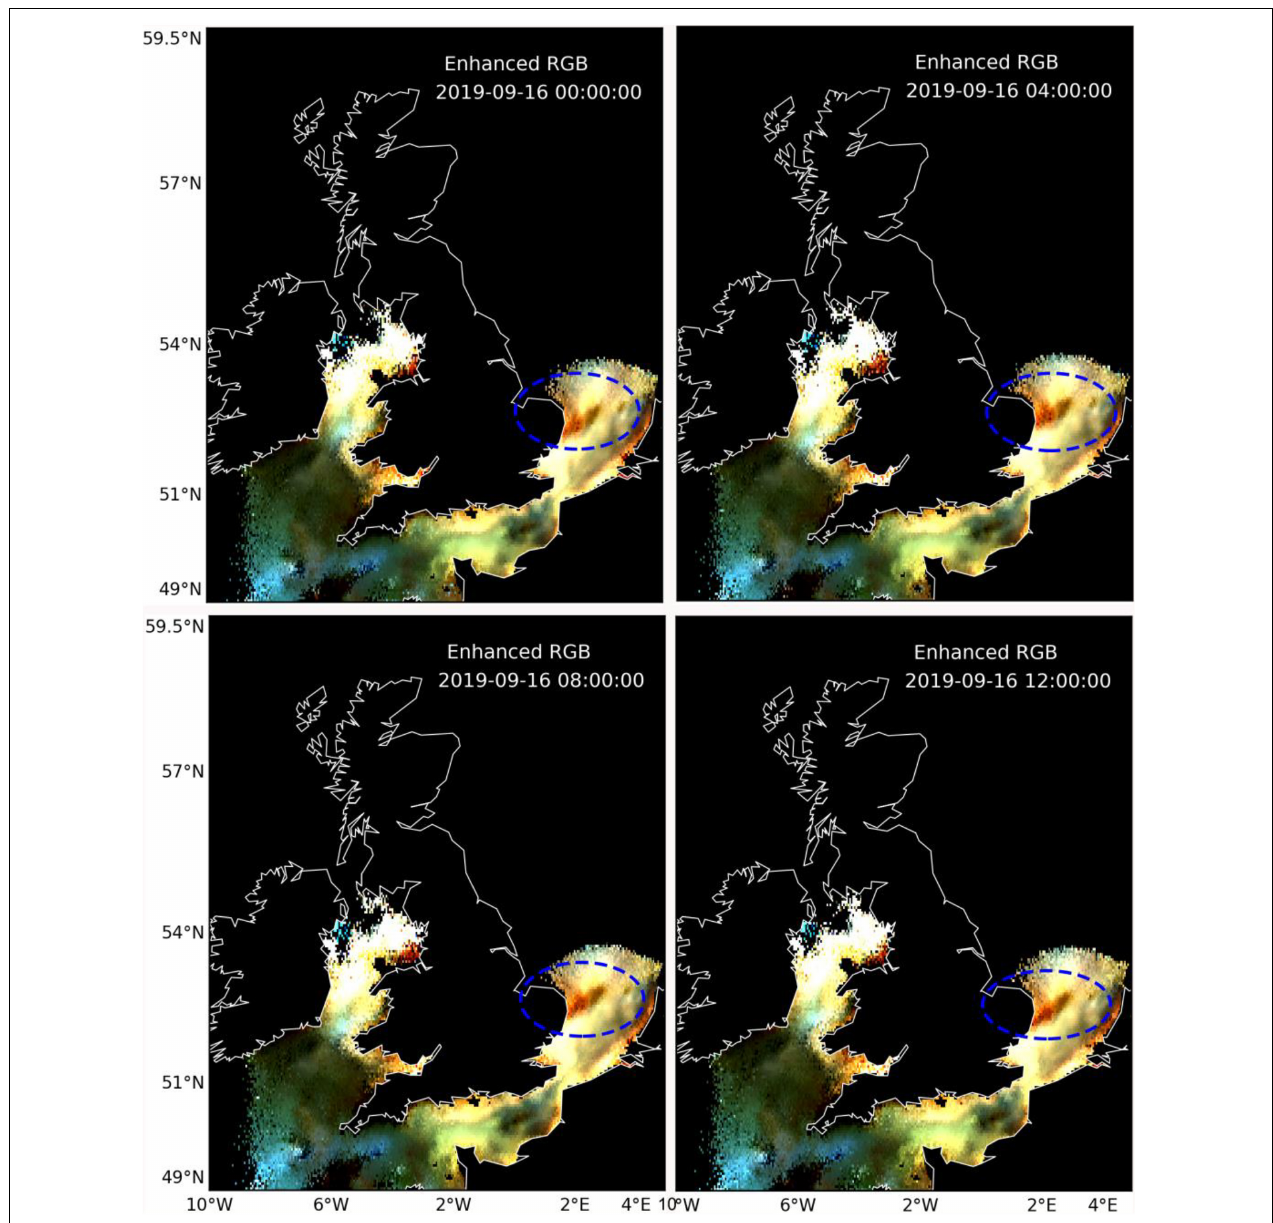
FIGURE 5 | Frames of predicted enhanced ocean-color RGB images indicating variabilities of water types (animation: https://rsg.pml.ac.uk/shared_files/junl/paper_animation/example1/rgb.gif).